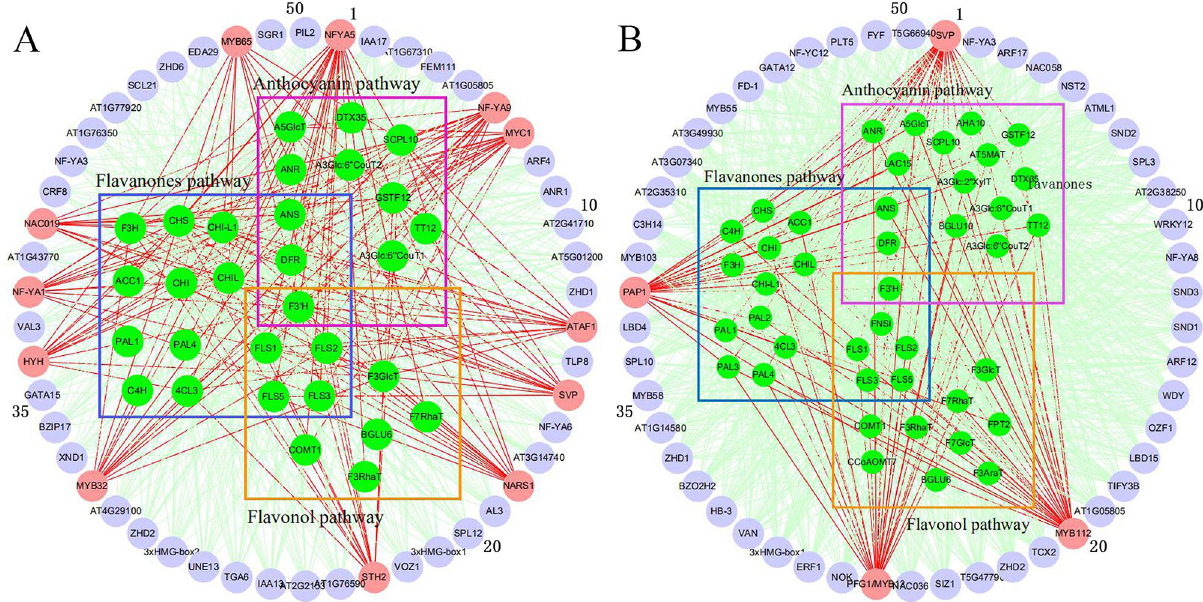
Figure 1. Regulatory network generated by triple-gene mutual interaction (TGMI) ( A ) and sparse partial least squares (SPLS) ( B ) for the Arabidopsis thaliana flavanone, flavonol and anthocyannin biosynthesis pathway using the microarray data generated from hypocotyledonous stem tissues. The green nodes represent pathway genes. All other nodes are the top 50 transcription factors that have the highest connectivity to pathway genes regardless of their colors. The light coral nodes represent positive known TFs of flavanone, flavonol and anthocyannin biosynthesis pathway while the red edges are to show the connections of a true positive known pathway regulator with pathway genes.